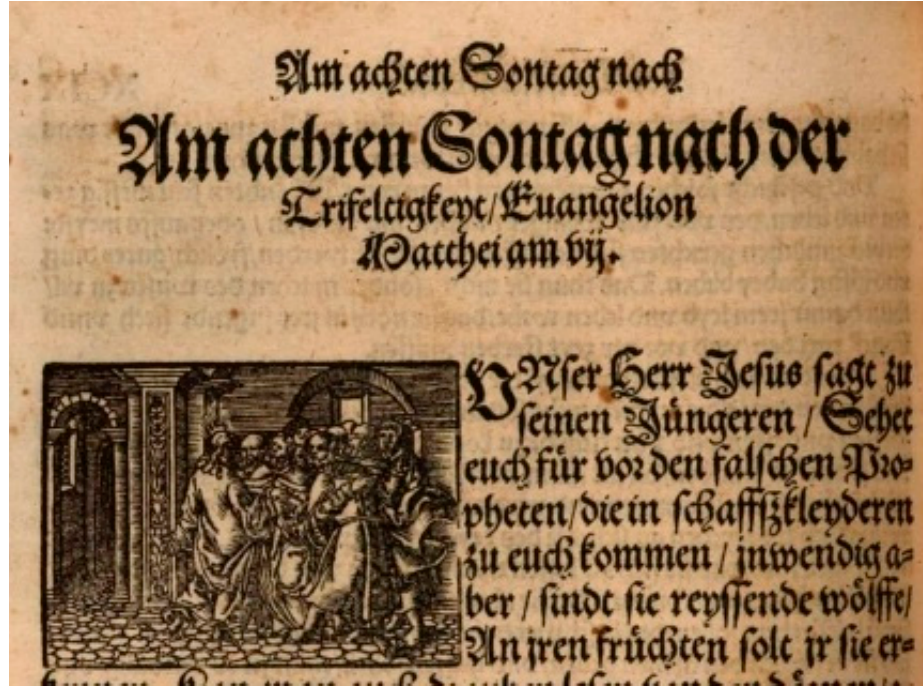
Figure 13. Christ with disciples [R 34] next to the pericope for the Eighth Sunday after Trinity in (Luther 1548, part 2, fol. XCIXv) (Munich, Bayerische Staatsbibliothek, 2 Hom. 281, urn:nbn:de:bvb:12-bsb10144040-5; NoC-NC/1.0).